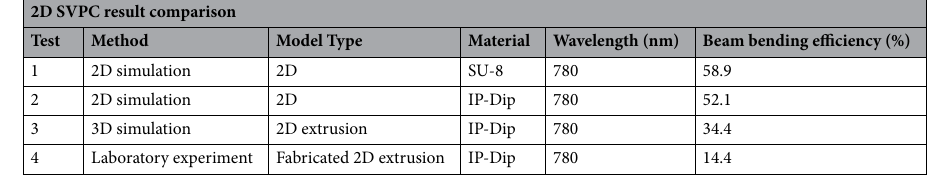
Table 1. Comparison of beam-bending efficiency of the SVPC Device. Table comparing 2D SVPC model types, materials, and bending efficiencies using different simulation and testing methods at 780 nm.